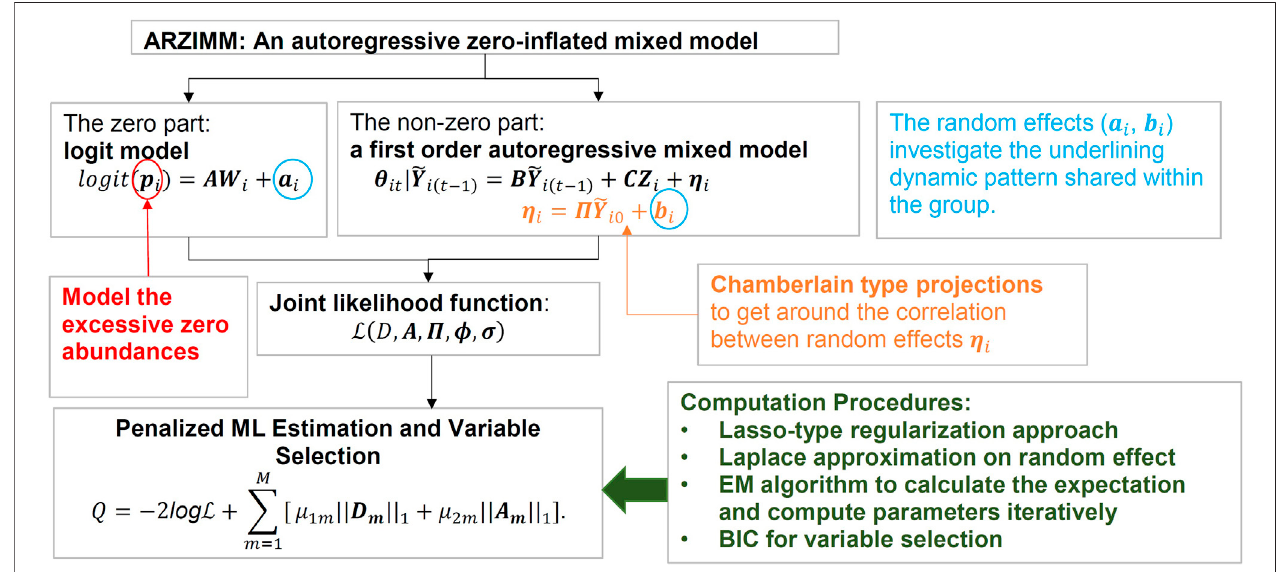
FIGURE 2 | Graphical representation of ARZIMM model and analytic